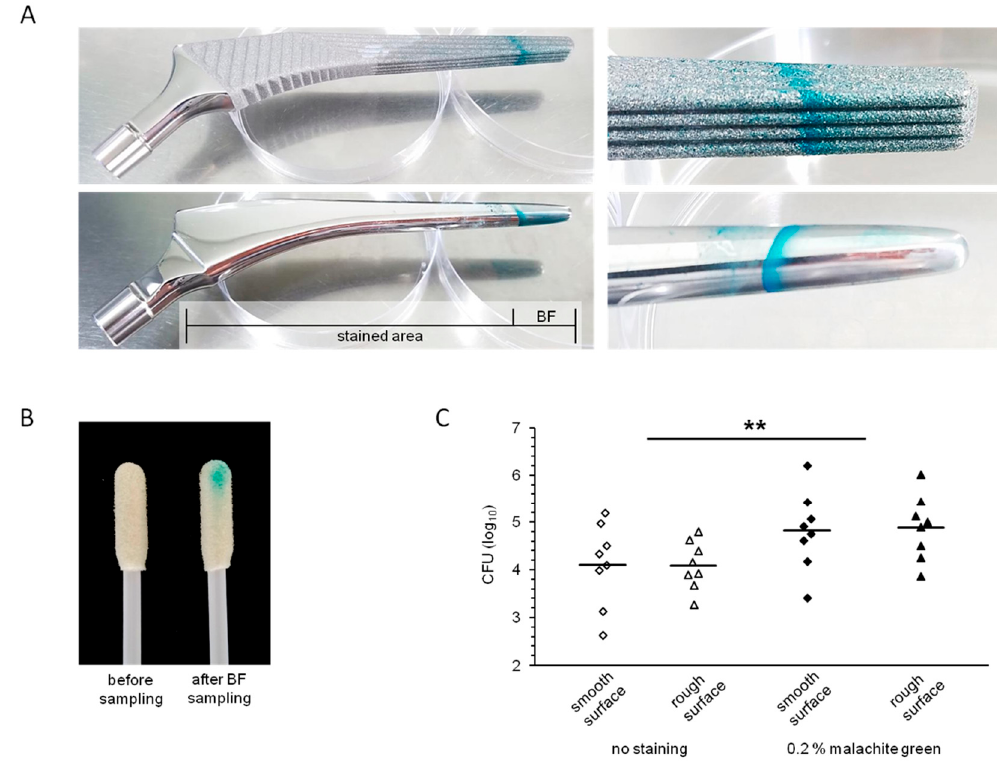
Figure 3. Staining and sampling of hip implant material. Biofilms (BF) of S. epidermidis were grown on two different hip implant materials: (i) LCU hip prosthesis (TiAl6V4 forged alloy, increased surface roughness) and (ii) standard C Cem hip prosthesis (polished steel alloy FeCrNiMnMoNbN). Biofilms were grown for three days and subsequently stained with malachite green (0.2% ( w/v )). Representative images of 4 independent experiments are given in the upper panel. Stained area and area of biofilm growth are indicated. A magnified close-up is shown on the right ( A ). Representative swabs before and after biofilm sampling are displayed ( B ). Recovered CFUs are given in log10 scale in the lower panel ( C ). Every experiment included two samplings per condition resulting in 8 data points each. Geometric means are indicated. Significance levels were calculated comparing stained biofilms with the non-staining setup. ** p < 0.01 (Student’s t -test, unpaired, two-tailed,